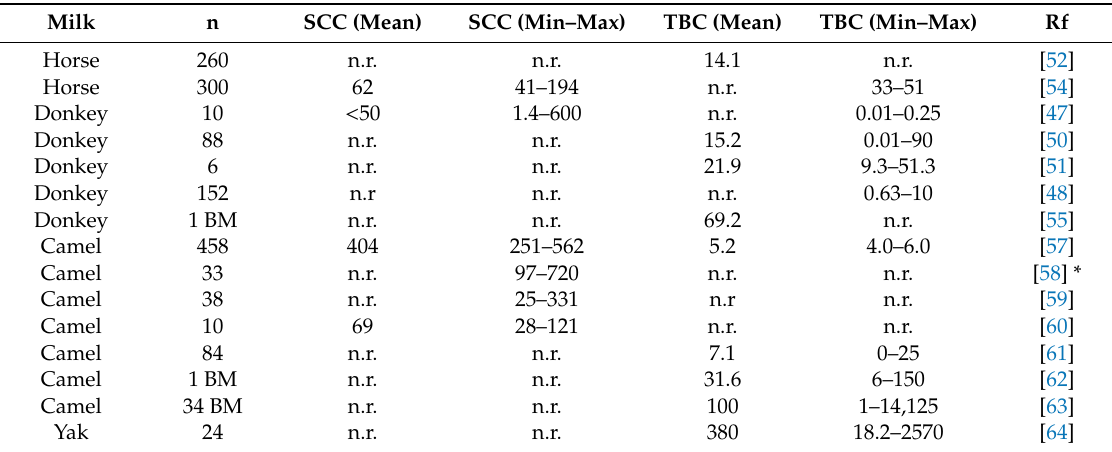
Table 2. Somatic cell counts (SCC, × 1000 mL − 1 ) and total bacterial counts (TBC, × 1000 mL − 1 ) of milk from minor dairy species. Rf =